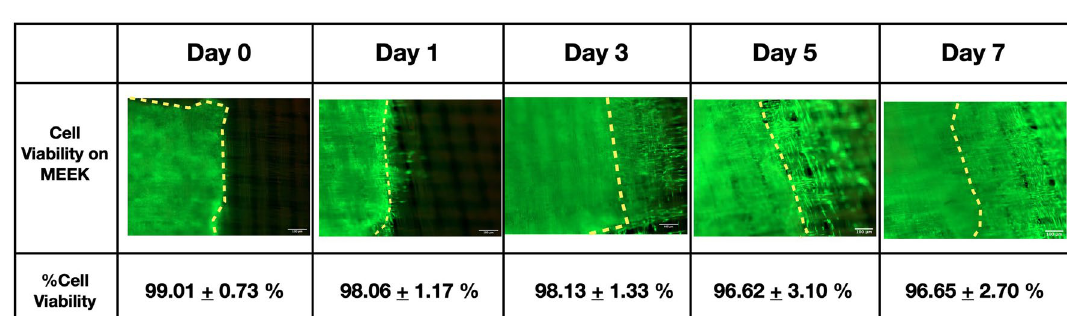
Figure 3. Cell viability of fibroblasts on 1:9 MEEK gauze. The fibroblast cell islands were stained with LIVE/ DEAD stain on days 0, 1, 3, 5 and 7, in which green and red fluorescence refer to live and dead cells, respectively. The cell viability was determined from an image analysis (n = 3). The yellow dotted lines indicate the edge of the fibroblast sheet island. The results are displayed as the mean ± SD (n = 10). The scale bars represent 100 the MEEK gauze, the fibroblasts mostly remained stationary during the first 24 h but moved forward from the periphery of the cell sheet islands along the fiber of the MEEK polyamide gauze, with the cells on the 1:6 MEEK gauze having the furthest migratory distance (Fig. 5 and Supplementary S2).